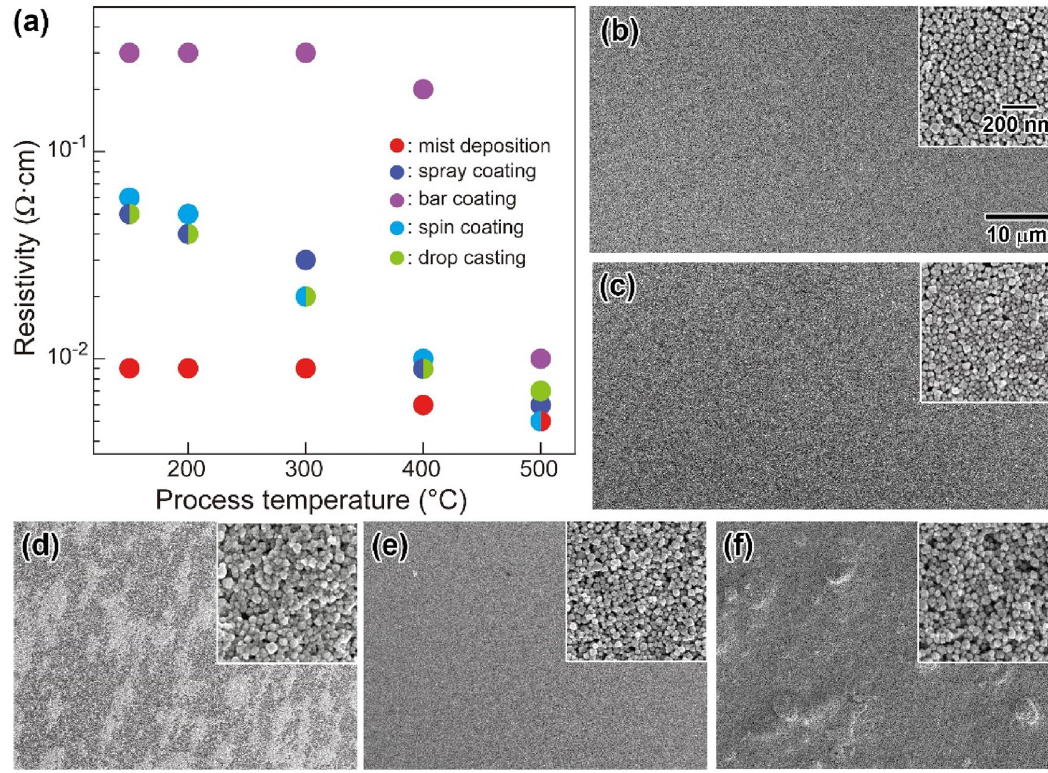
Figure 4. ( a ) Resistivity of the P1 thin films on glass substrates obtained by the different preparation methods. The resistivity was measured after annealing at various process temperatures in Ar-H 2 (4% H 2 ) for 1 h. SEM images of the surfaces of the P1 thin films on glass substrates prepared by the ( b ) mist deposition ( c ) spray coating, ( d ) bar coating, ( e ) spin coating, and ( f ) drop casting methods. These images were taken after annealing at 150 °C. The insets in ( b )–( f ) are close-up images of the surfaces. The scale bar shown in ( b ) is common to all